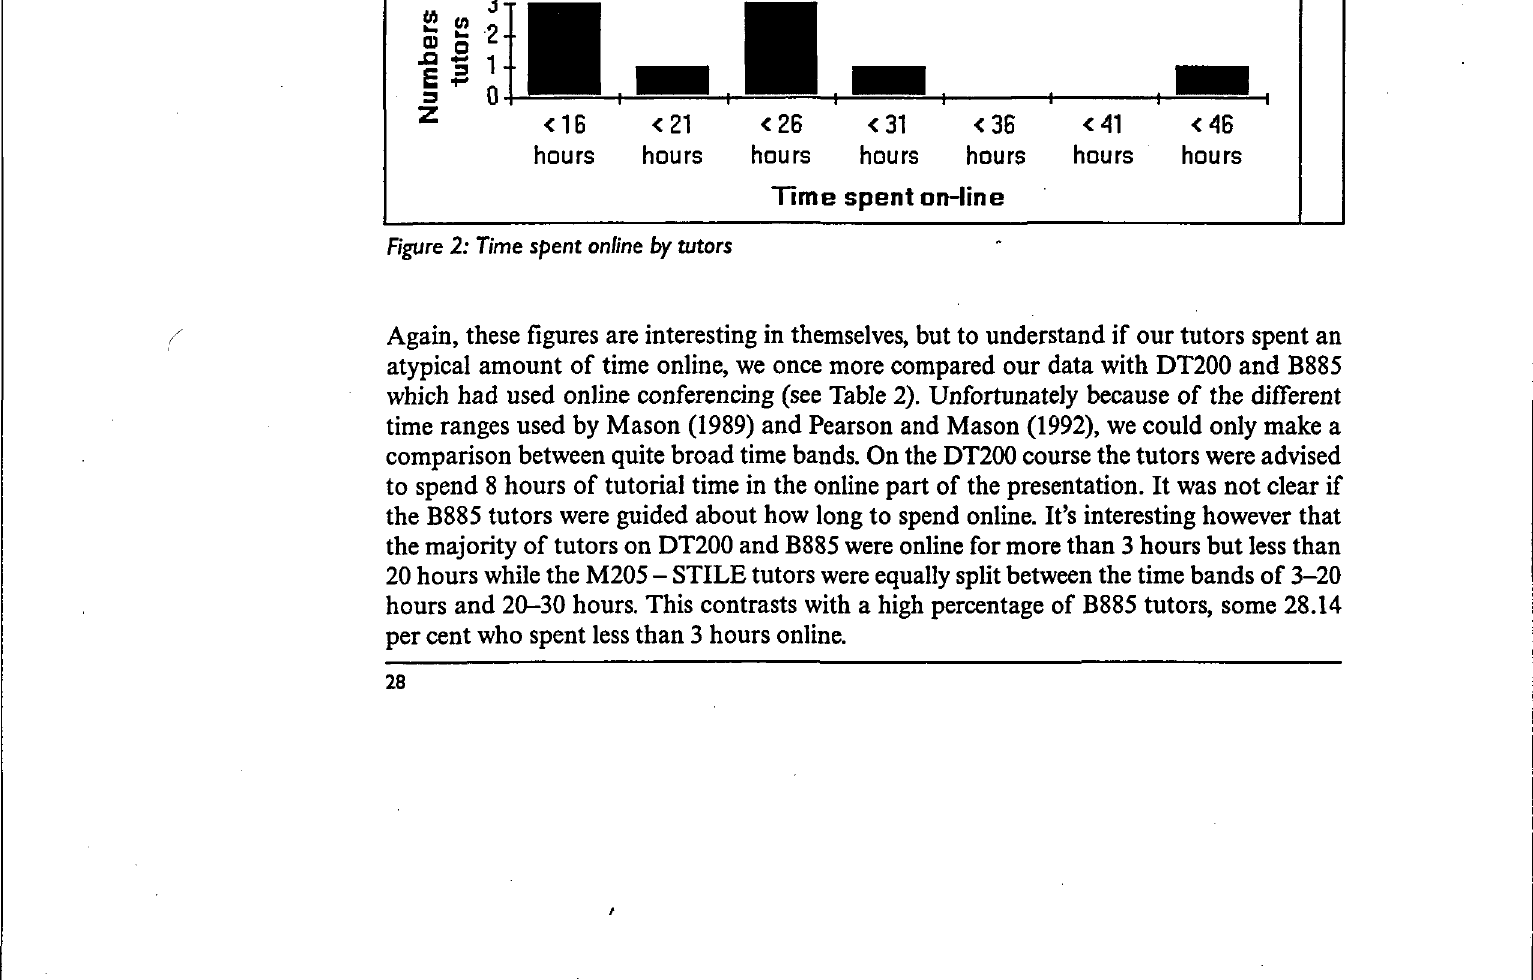
figure 2: Time spent online by